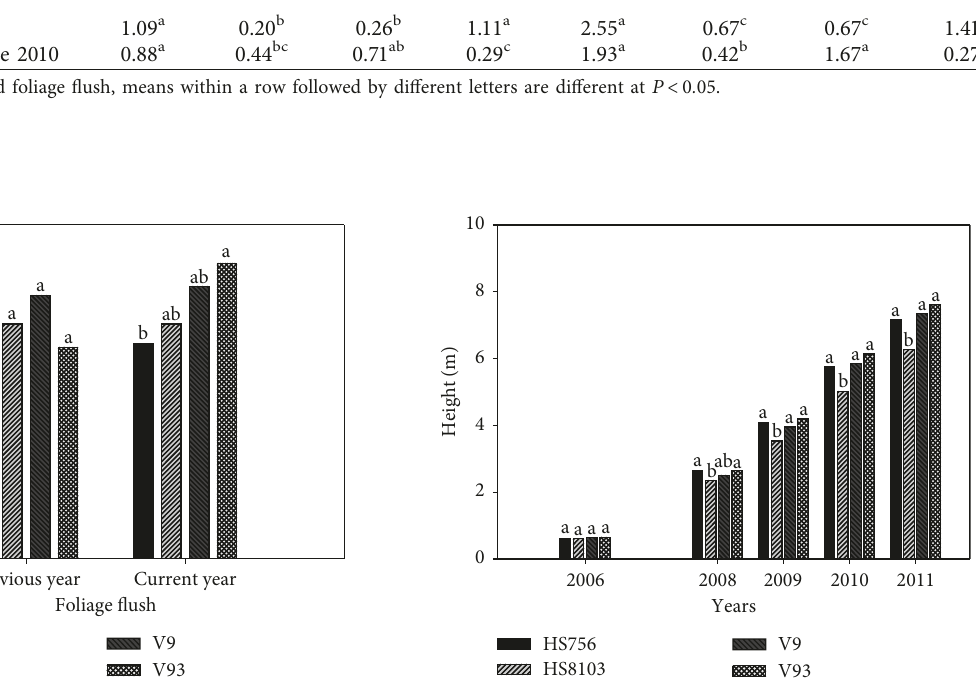
Figure 2: Crown intrinsic water use efficiency of previous- and current-year foliage flushes of loblolly pine genotypes from the eastern portion of the species’ range grown at a site in North Central Louisiana in 2009.